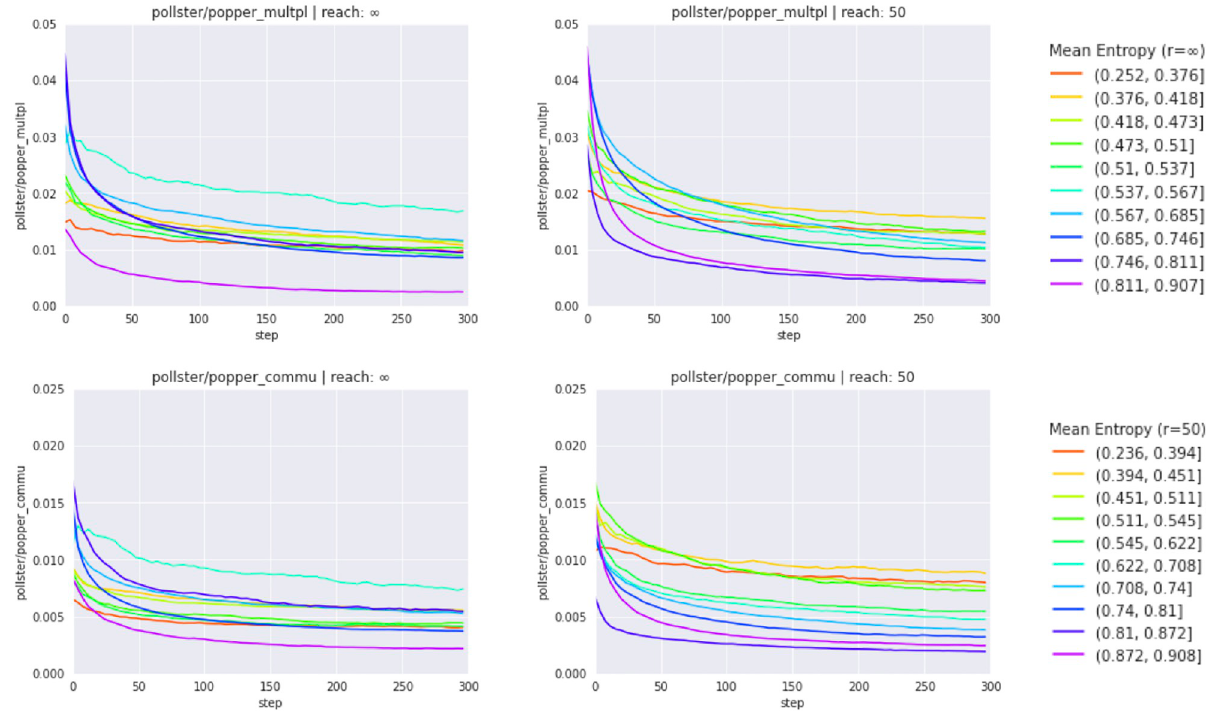
Fig 2. Evolution of Popper metrics. Evolution of Popper metrics P OPPER C OMMU ( commutativity ) and P OPPER M LTPL ( multiplication ) during self- training. Left: inferentially closed pre-training corpora ( reach = 1 ); right: inferentially incomplete pre-training corpora ( reach =50). Metric evolutions are aggregated over all agents whose belief systems display a similar doxastic entropy (cf. bins to the very right).